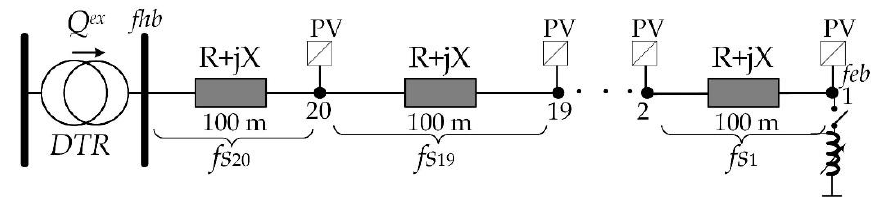
Figure 10. Equivalent circuit of an LV feeder where the distributed Q ( U ) or concentrated L ( U ) local control strategies can be applied.